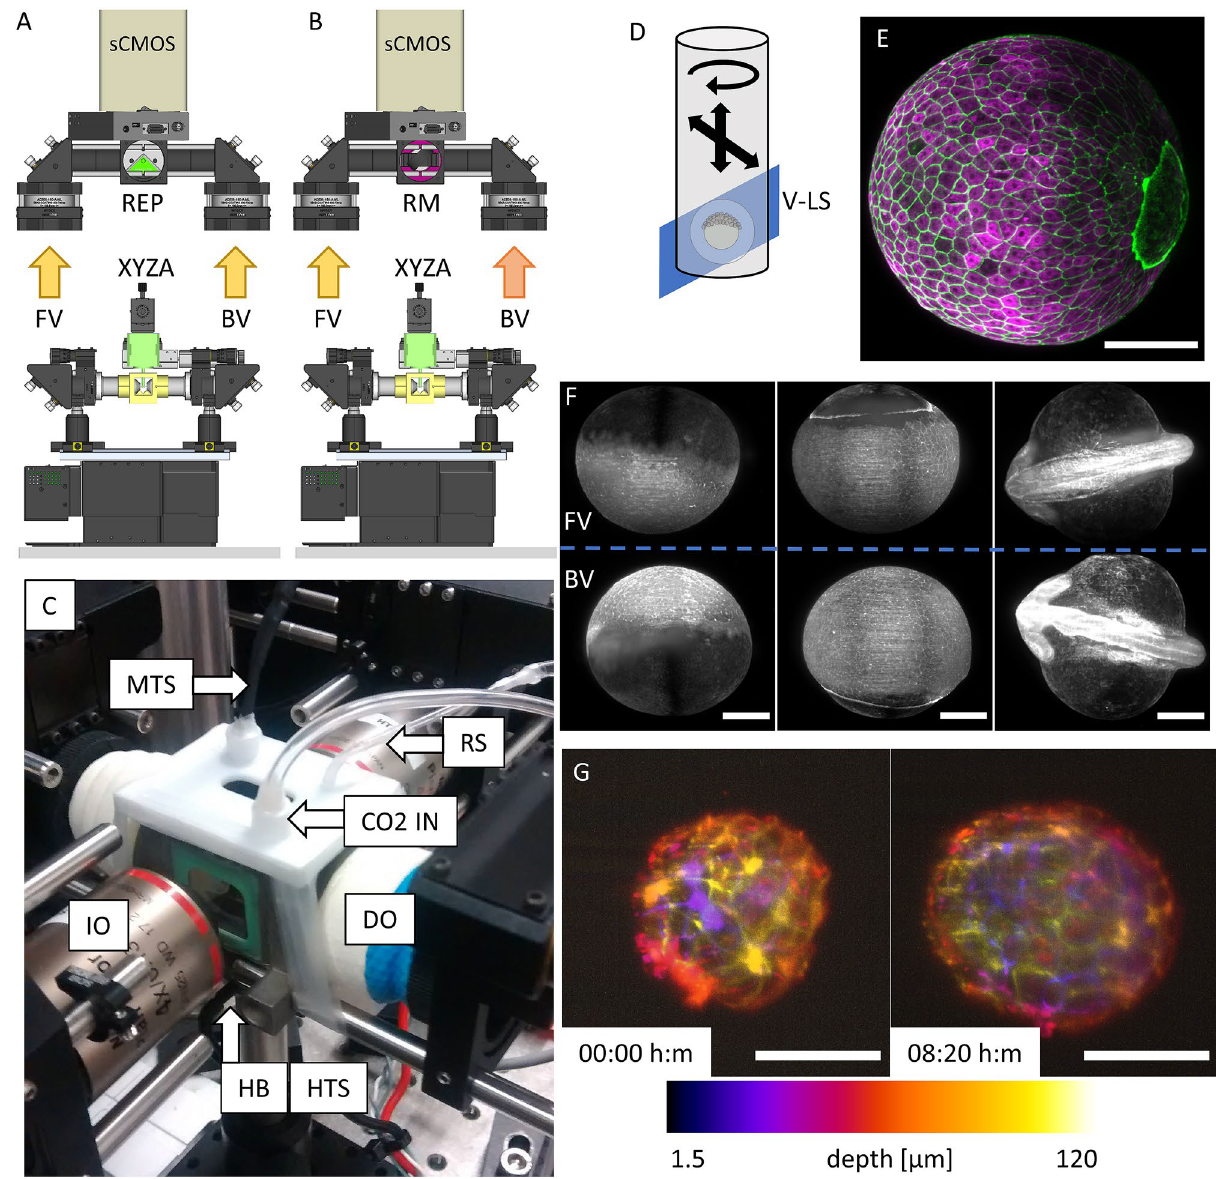
Figure 3. ( A , B ) The setup implementation in the Classic LSFM modality, for ( A ) simultaneous and ( B ) alternate double side detection (FV: front view, BV: back view), using a sCMOS scientific camera (sCMOS). The path selector is a right-edge prism (REP) in (A) and a rotating mirror (RM) in ( B ). ( C ) Photo of the 316L steel imaging chamber, with the two air illumination objectives (IO) and the two sealed water detection objective (DO). MTS medium temperature sensor, RS refilling system, CO2 IN CO 2 inlet, HB heater block, HTS heater temperature sensor. ( D ) Exemplification of the sample mounting and scanning system. The sample position can be controlled in 3D and rotated (XYZA) around its vertical axis. V-LS vertical light-sheet. ( E ) Maximum intensity projection of a fixed zebrafish embryo at 90% epiboly, labeling actin (green) and tubulin (magenta), showing multicolor capability and achieving homogenous excitation thanks to the double illumination scheme. Scale bar 200 µm. ( F ) Maximum intensity projections from 3 time points of a time lapse movie recording an unconstrained developing zebrafish embryo (actin-GFP) from blastula to segmentation stages. The REP was used to register the front (top) and back (bottom) views onto the same camera chip, at the same time. A double illumination scheme was used for excitation. Scale bars 200 µm. ( G ) Depth colored intensity projection of an E-Cadherin-GFP mouse embryo at E4.5 stage (left) and after about 8 h (right) of imaging. Temperature and pH were conditioned within the imaging chamber, enabling cells proliferation and embryo’s development. The entire volume of the mouse embryo has been imaged every 10 min, through the RM, i.e. alternating the detection of front and back views. The showed images are obtained from the fusion of the two views. Scale bars 100 µm. ( A , B ) created with FreeCAD 0.16 (www. freec adweb. org) and ( D ) created with Autodesk Inventor Professional 2015 (www. autod esk.